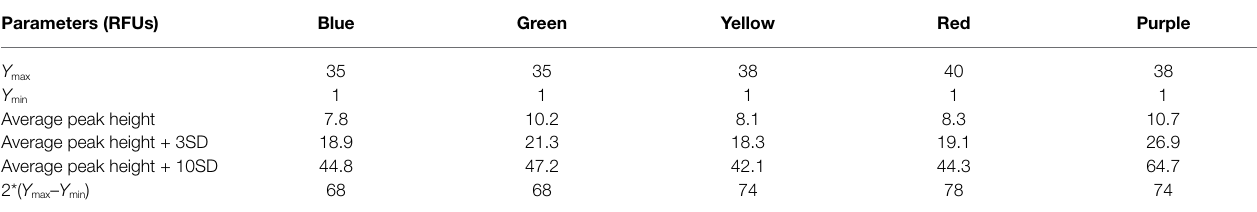
SD, standard deviations; Y max , highest peak height; Y min , lowest peak